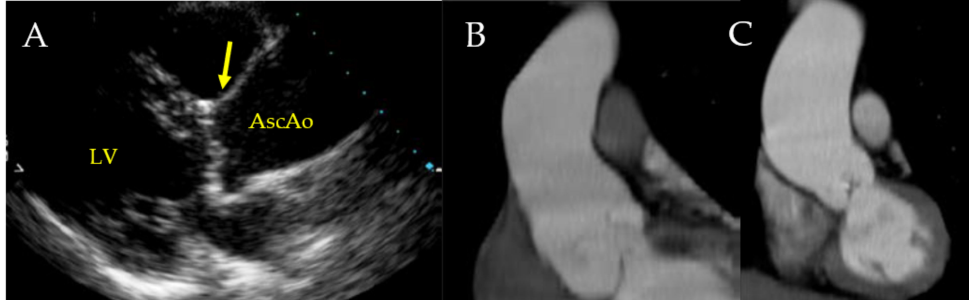
Figure 11. ( A – C ). Depicts representative findings on echocardiography and computed tomography (CT). In ( A ), the transthoracic echocardiogram shows normal dimensions of the sinuses of Valsalva (arrow) and a dilated ascending aorta. Ascending aorta denotes proximal ascending aorta, and LV denotes left ventricle. In ( B , C ), the CT images reveal dilatation of the aortic root and dilatation of the ascending aorta and proximal arch, respectively. Licenses Centre Cardiologique du Nord; order date 27 July 2022; order number 5357160571198; publication NEJM; Title: Aortic Dilatation in Patients with Bicuspid Aortic